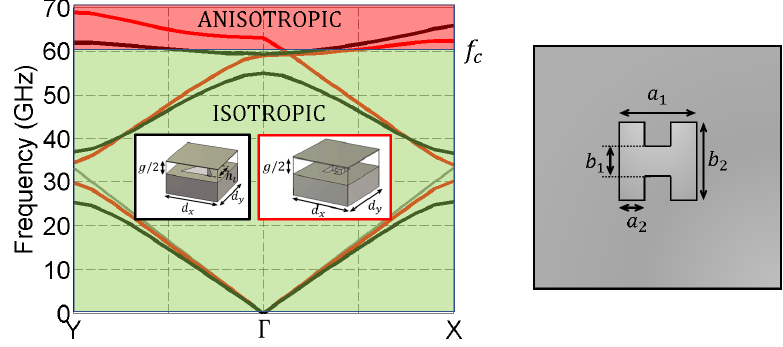
Figure 8. Dispersion diagram of two mirror-symmetric structures with triangular (black lines) and double-ridged (red lines) holes. The right panel shows a detail of the double-ridged hole. The light line is displayed in gray. The cutoff frequency of the triangular and double-ridged waveguides is chosen to be the same, f c = 60GHz. Independently of the shape of the holes, the anisotropy of the structures is hardly noticeable below the cutoff frequency (green region). The geometrical parameters of the unit cells are: h hole = 1.5mm, g = 0.2mm, d x = d y = 4.5mm, h t = 2.88mm, a 1 = b 2 = 1.46mm, and a 2 = b 1 = a 1